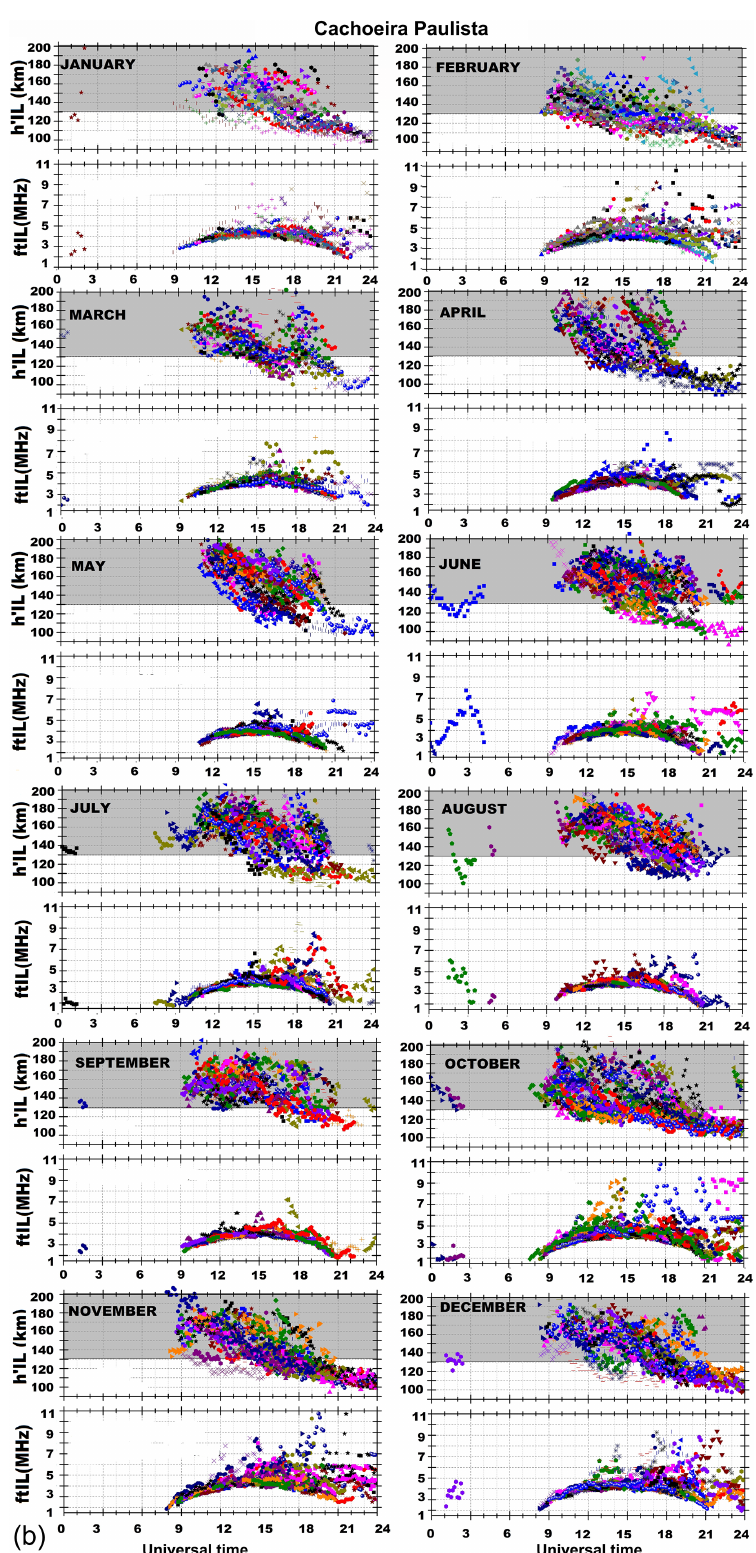
Figure 4. (a) Time variation of the virtual height ( h (cid:48) IL) and top frequency of intermediate layers (ftIL) over São Luís from March to December 2009. Different colors are used to represent the different days of each month. (b) Same as Fig. 4a, but for Cachoeira Paulista from January to December